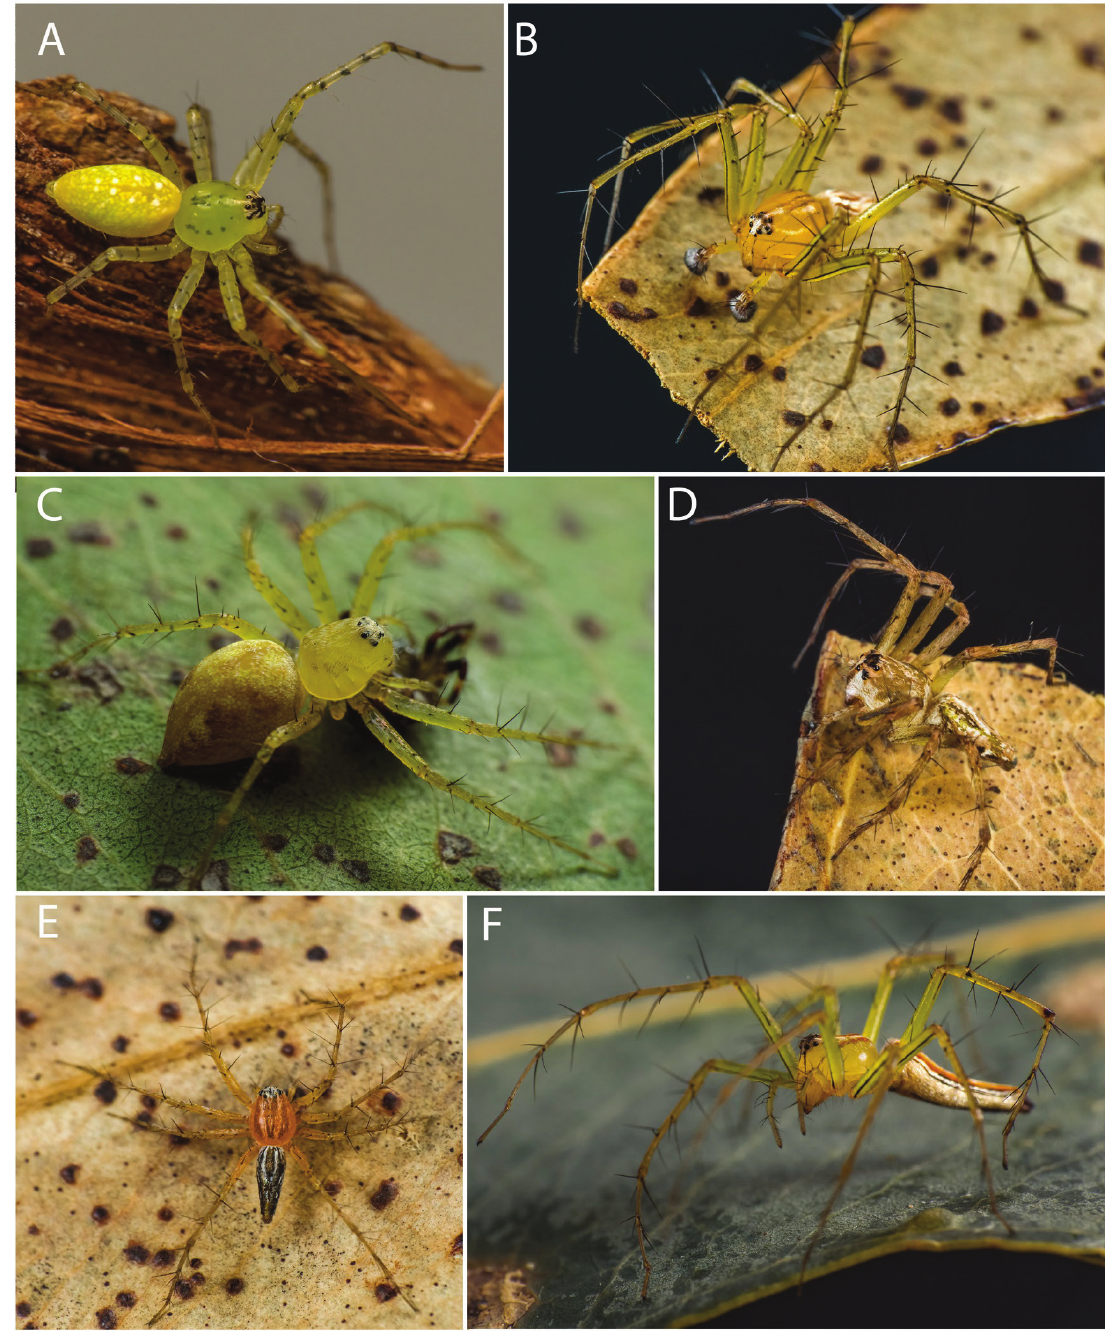
Figure 1. Live images of Oxyopes species from Australia: A , Oxyopes punctatus L. Koch, 1878; B , Oxyopes sp. indet.; C , Oxyopes sp. indet.; D , Oxyopes sp. indet.; E , Oxyopes sp. indet.; and F , Oxyopes macilentus L. Koch, 1878. Images: Robert